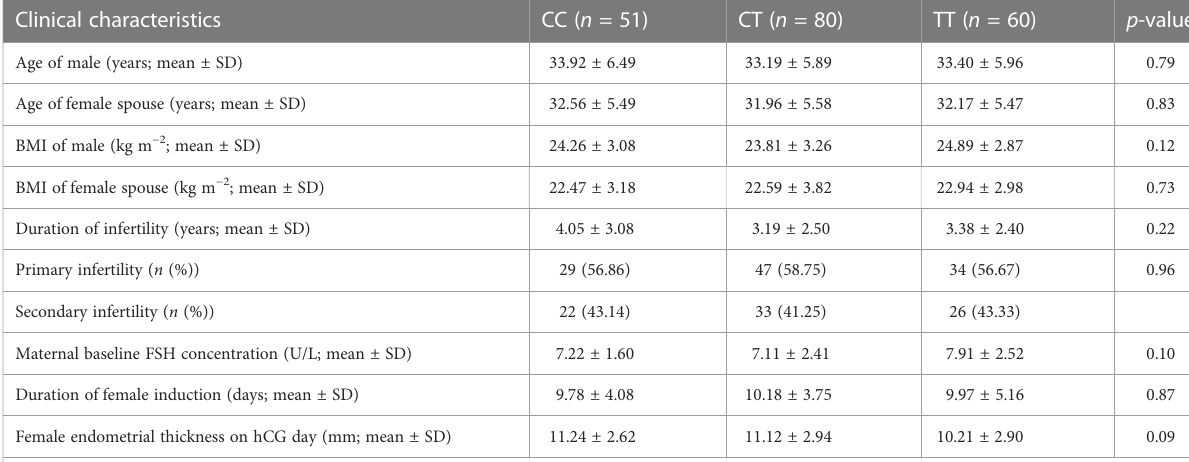
TABLE 2 Characteristics of the patients enrolled in this study. Clinical